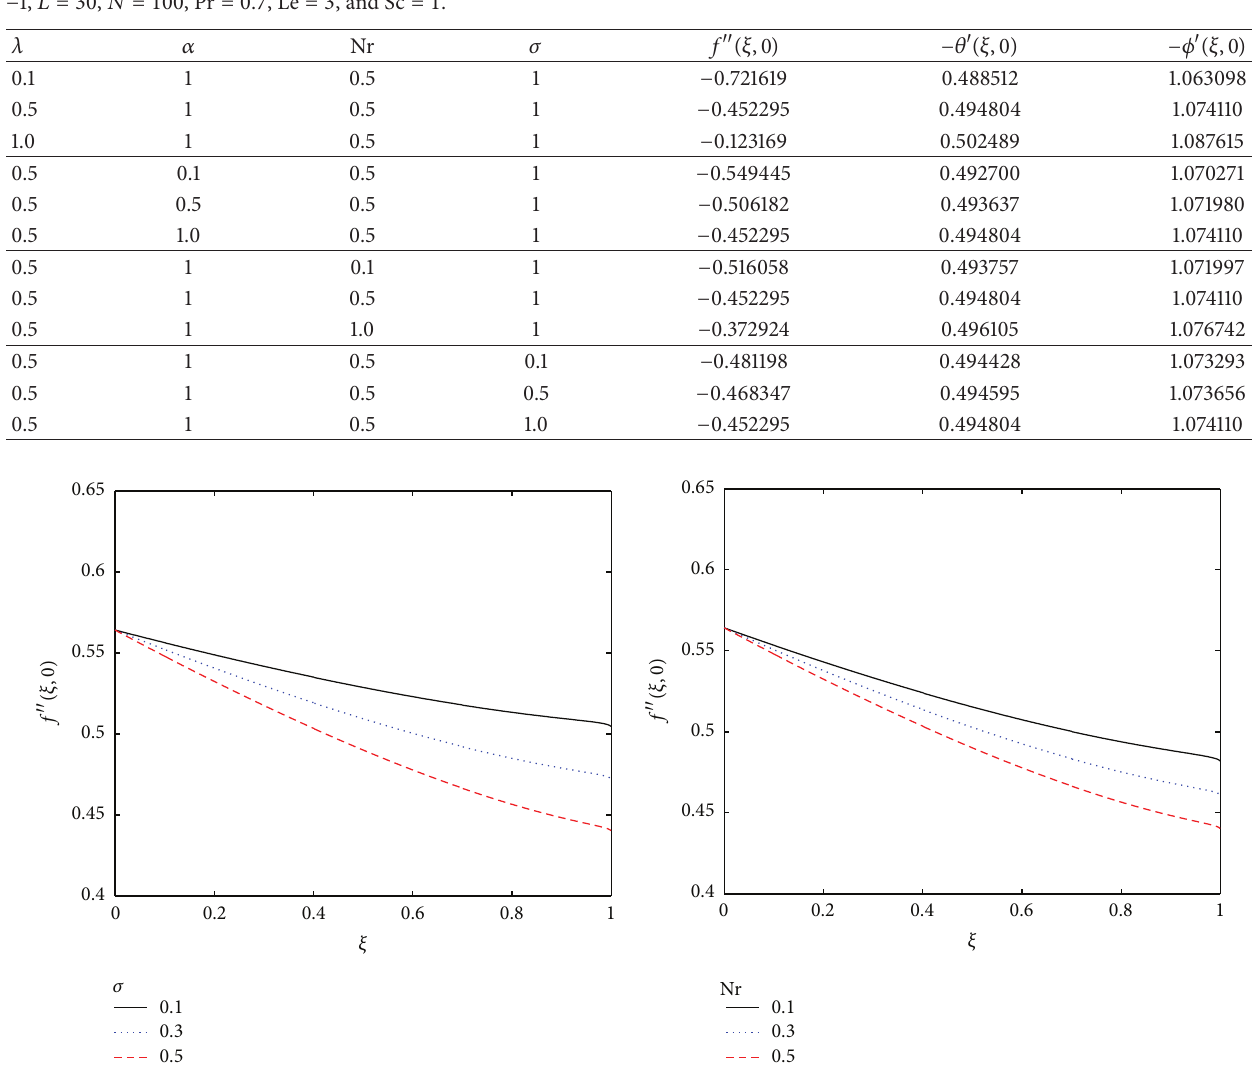
Table 2: Variation of the SHAM approximate solutions of 𝑓 󸀠󸀠 (𝜉, 0) , −𝜃 󸀠 (𝜉, 0) , and −𝜙 󸀠 (𝜉,0) for different flow parameters. 𝑀 = 𝐾 = 30 , ℎ = −